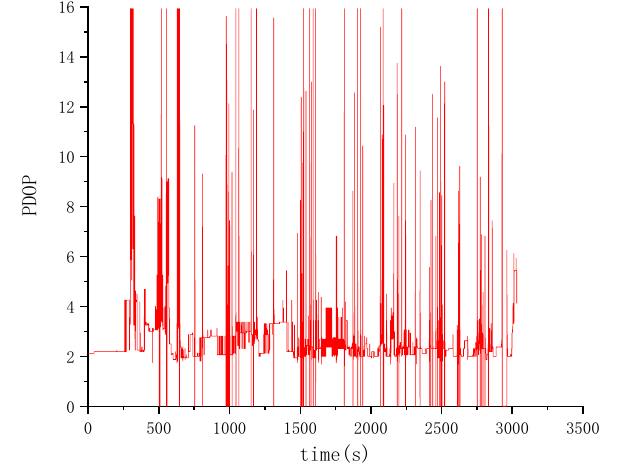
Figure 7. PDOP values of BDS.